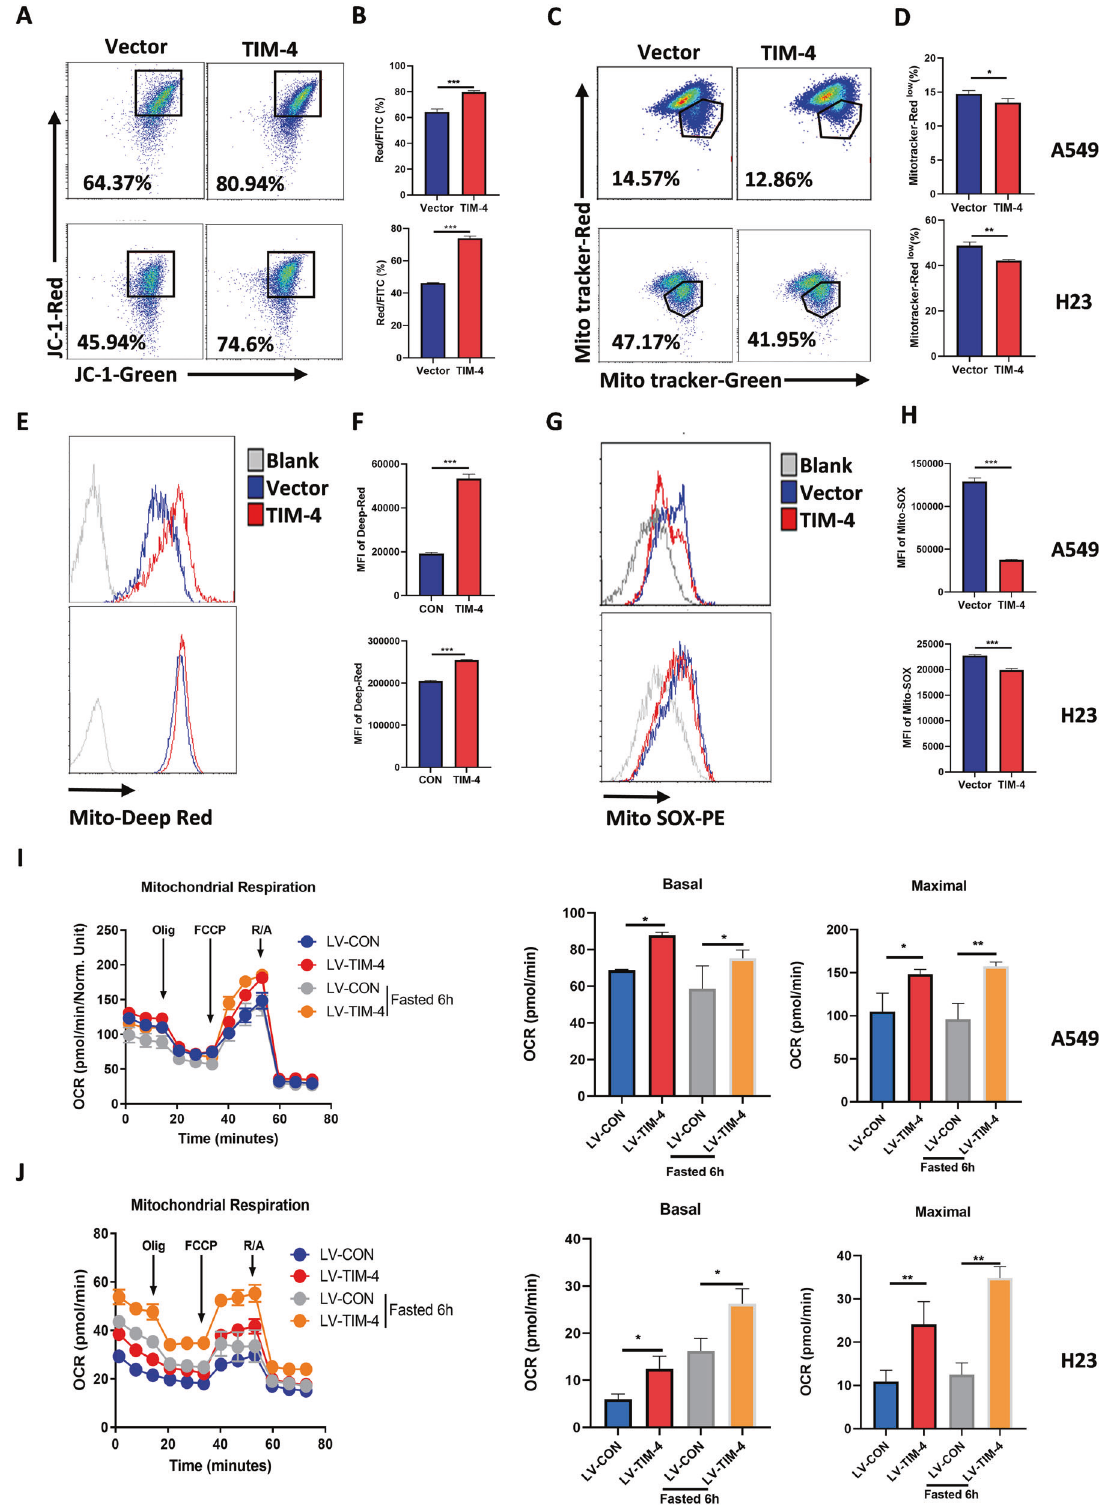
Fig. 2 TIM-4 enhances mitochondrial activity and fi tness of lung cancer cells. A , B Mitochondrial membrane potential (JC-1 aggregates) in A549 and H23 cells were accessed by the JC-1 assay kit according to the manufacture ’ s instruction. C , D Flow cytometry dot plots showed the percentage of depolarized mitochondria in A549 and H23 cell lines transfected with LV-CON or LV-TIM-4. E , F Mitochondria fi tness was tested with Mito-tracker Deep Red. G , H Mitochondrial ROS levels of LV-A549 cells and LV-H23 cells were accessed by assay kit. I , J OCR, mitochondrial basal respiration and maximal respiration of LV-A549 cells and LV-H23 cells after fasted (Glucose:1 mM). Three independent experiments were conducted for each result and error bars represent SEM per group in one experiment. Data were analyzed using Student ’ s t test (two-tailed unpaired t test). ns means non-signi fi cance; * P < 0.05; ** P < 0.01; *** P < 0.001.